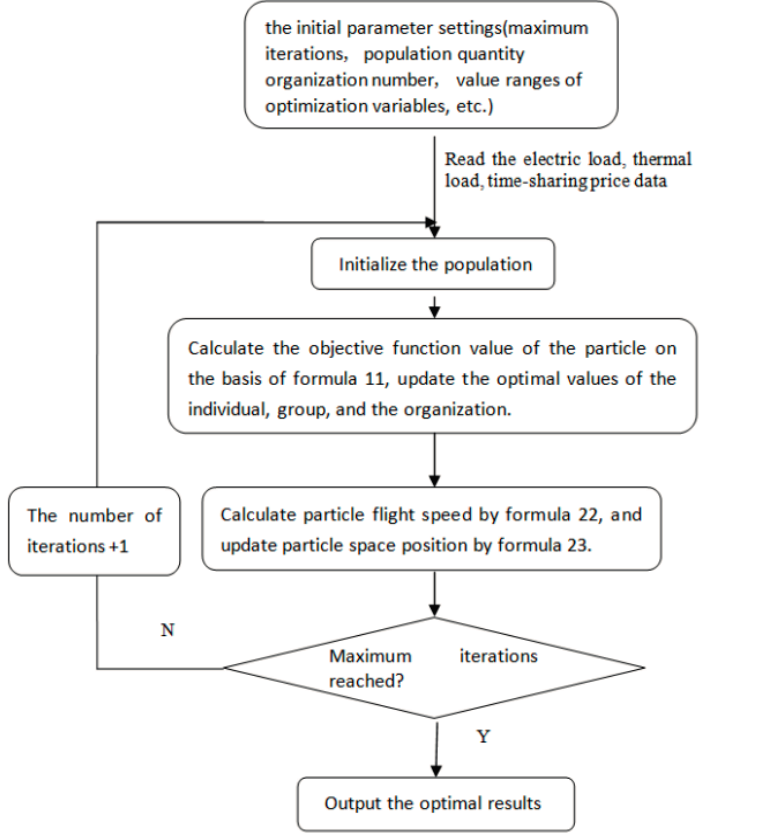
Figure 1. The flow chart of hybrid energy optimal